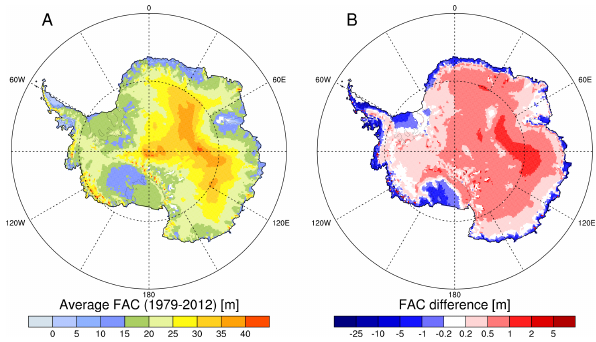
Figure 1. Average firn air content (FAC) for 1979–2012 (a) , sim- ulated by the time-dependent model, and the difference between (a) and the steady-state model (b) , from Ligtenberg et al. (2011) (Fig. 8a). The FAC represents the height difference of the column (in meters) that remains when the firn layer is compressed to ice density (here assumed to be 910kgm − 3 ).